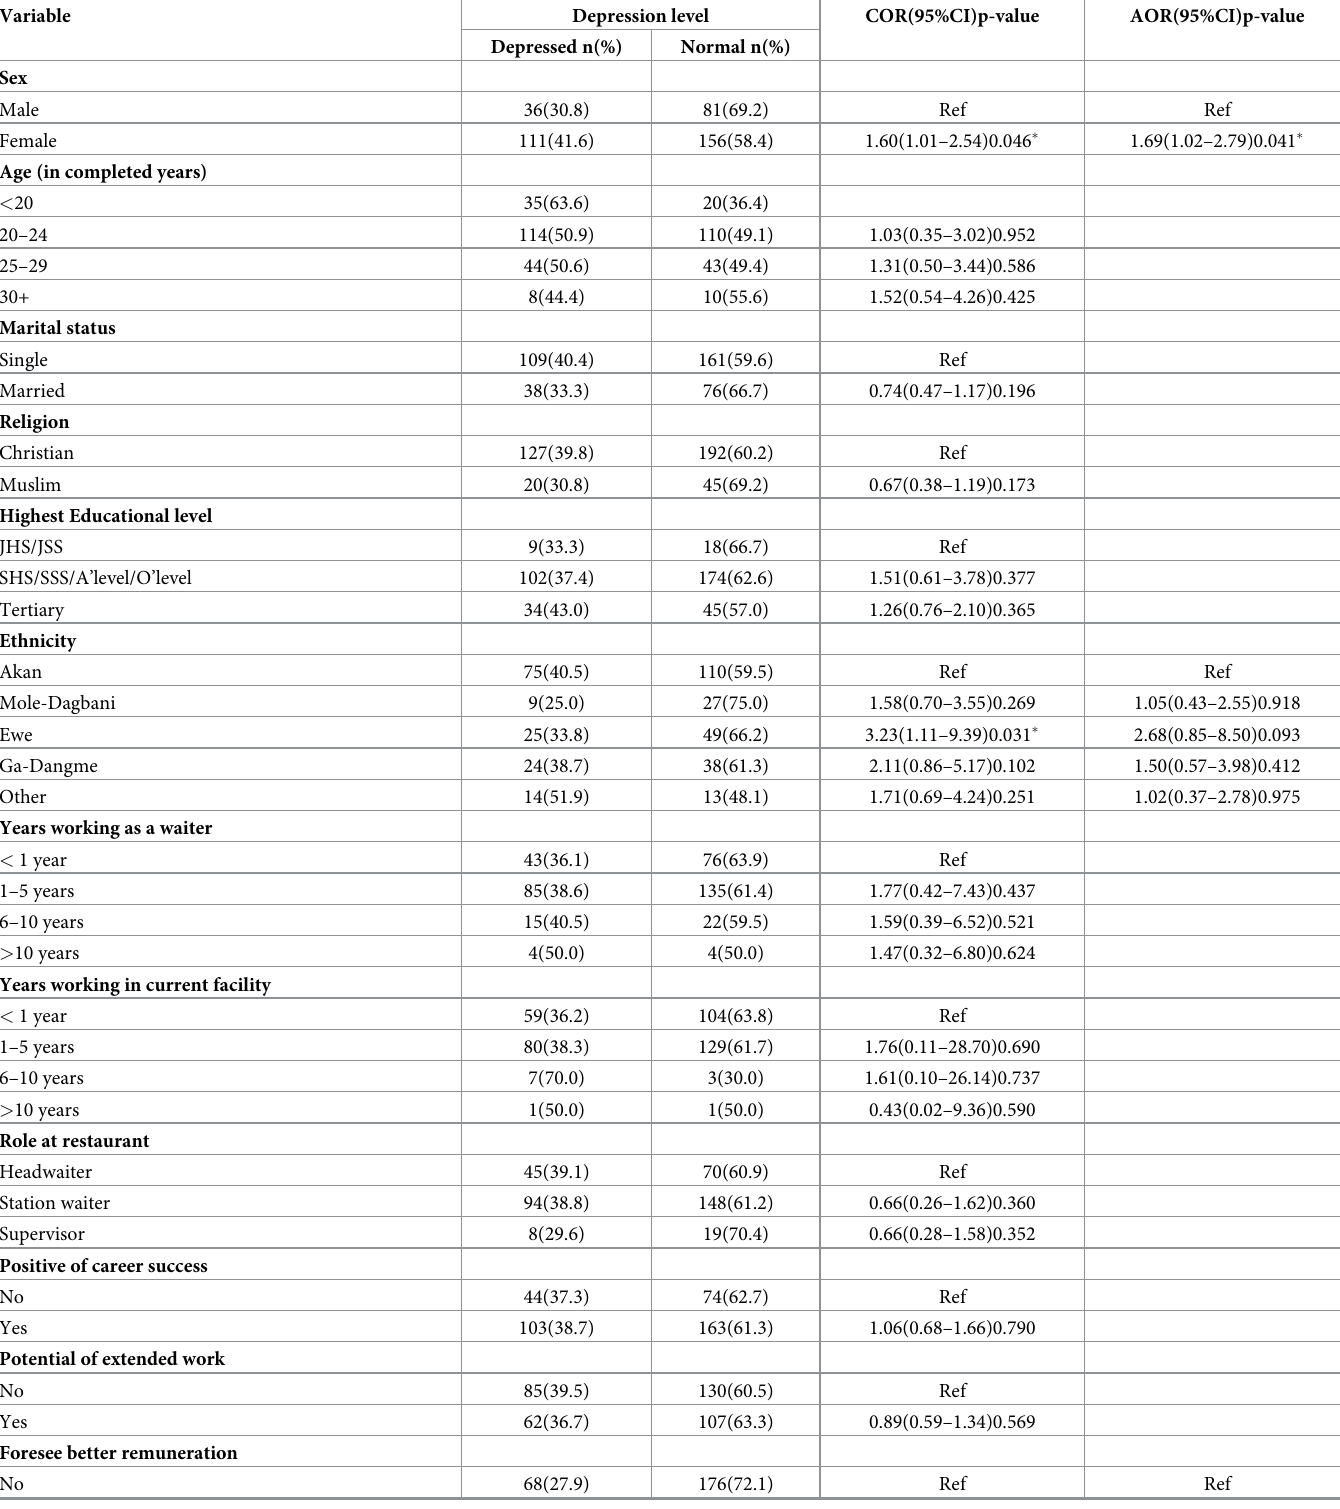
Table 4. Predictors of depression among